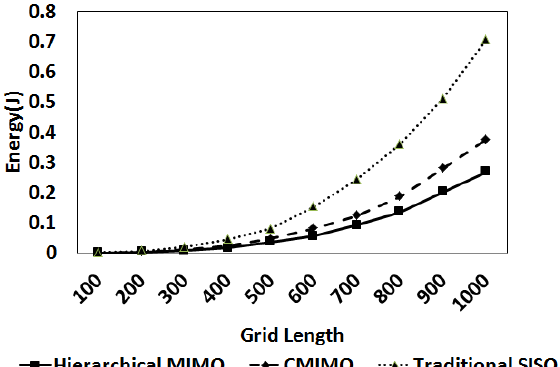
Figure 4. Energy (J) comparison for three algorithms.